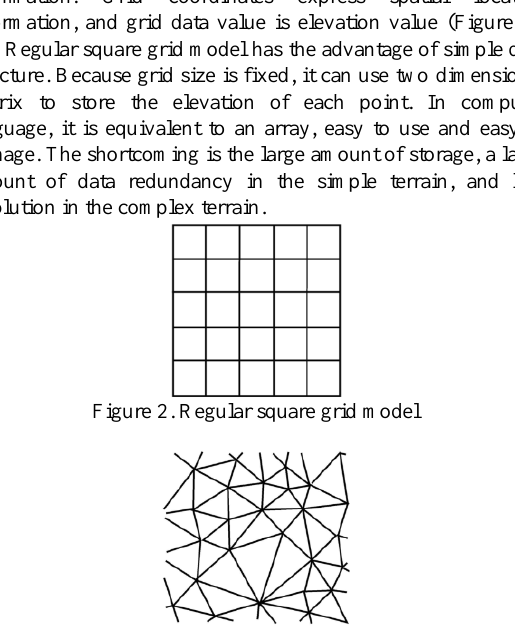
Figure 3.Triangulated irregular network